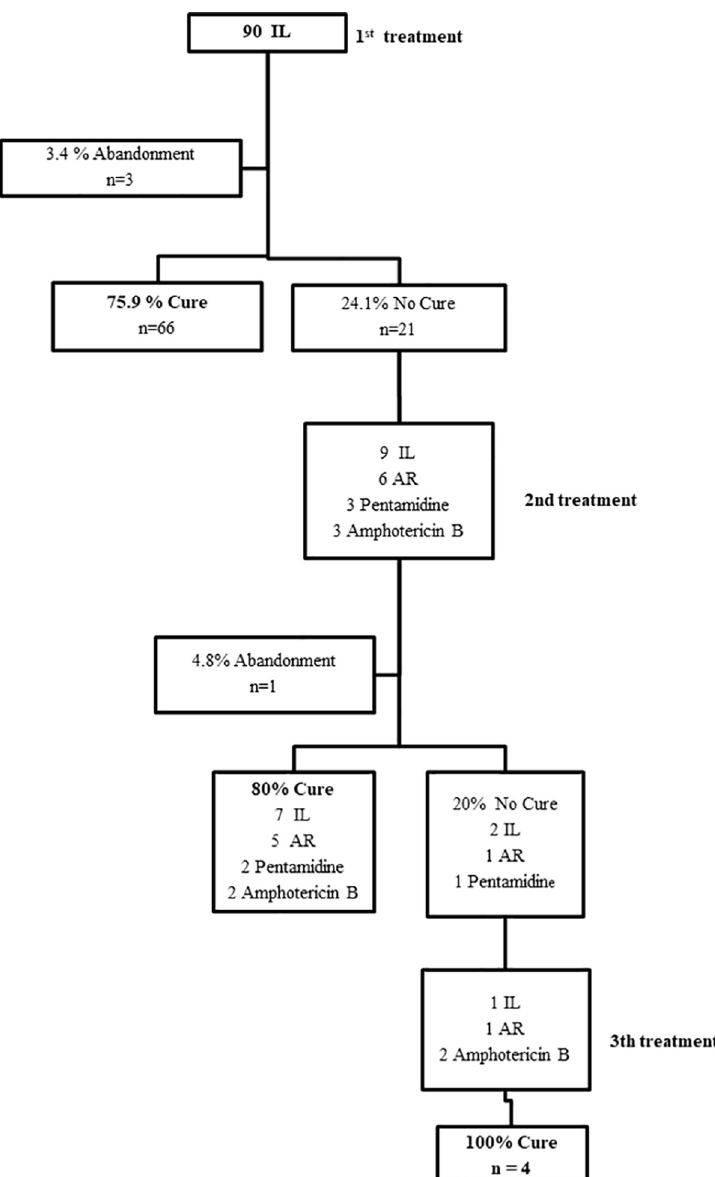
Fig 4. Patients follow-up: intralesional route. IL- intralesional route; AR- alternative regimen; SR- standard